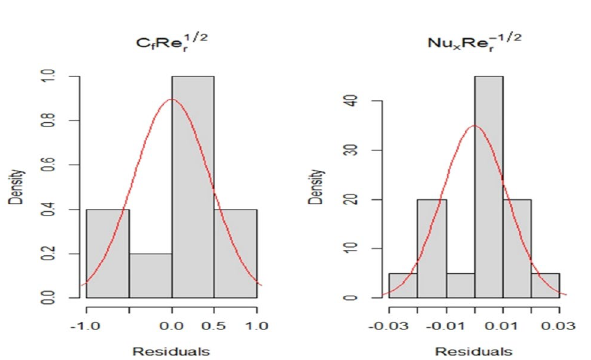
Q ) plot for Cf √ Re x and Nu / √ Re x . −